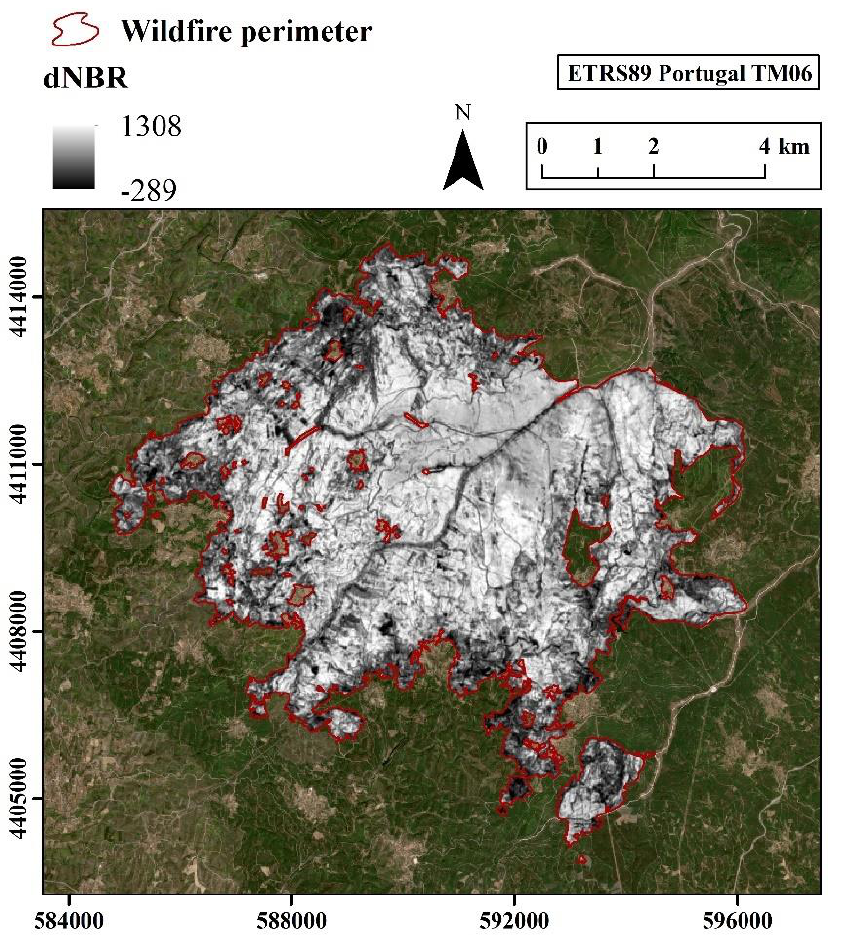
Figure 2. Fire severity within the wildfire scar assessed through the differenced Normalized Burn Ratio (dNBR) index computed from pre- and post-fire Sentinel-2